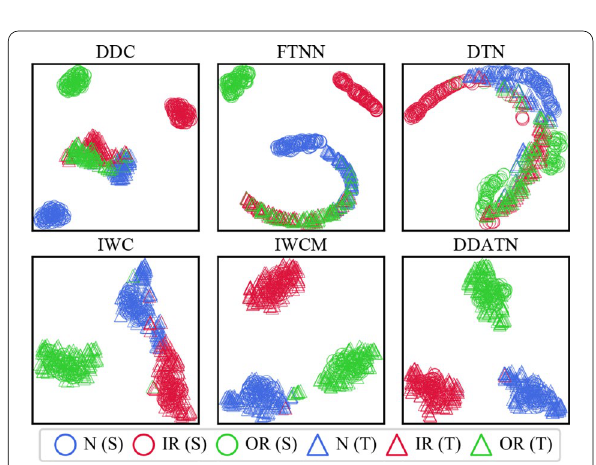
Figure 7 Feature visualization of task 36 (CW0.53_3 to